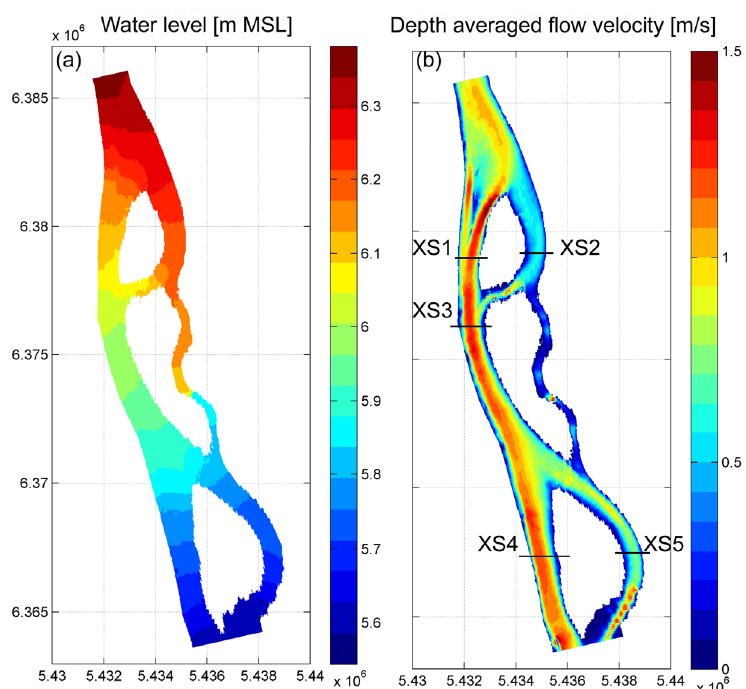
Figure 4. Simulated maps of ( a ) water level and ( b ) depth-averaged flow velocity at a river discharge of 13,600 m 3 /s.